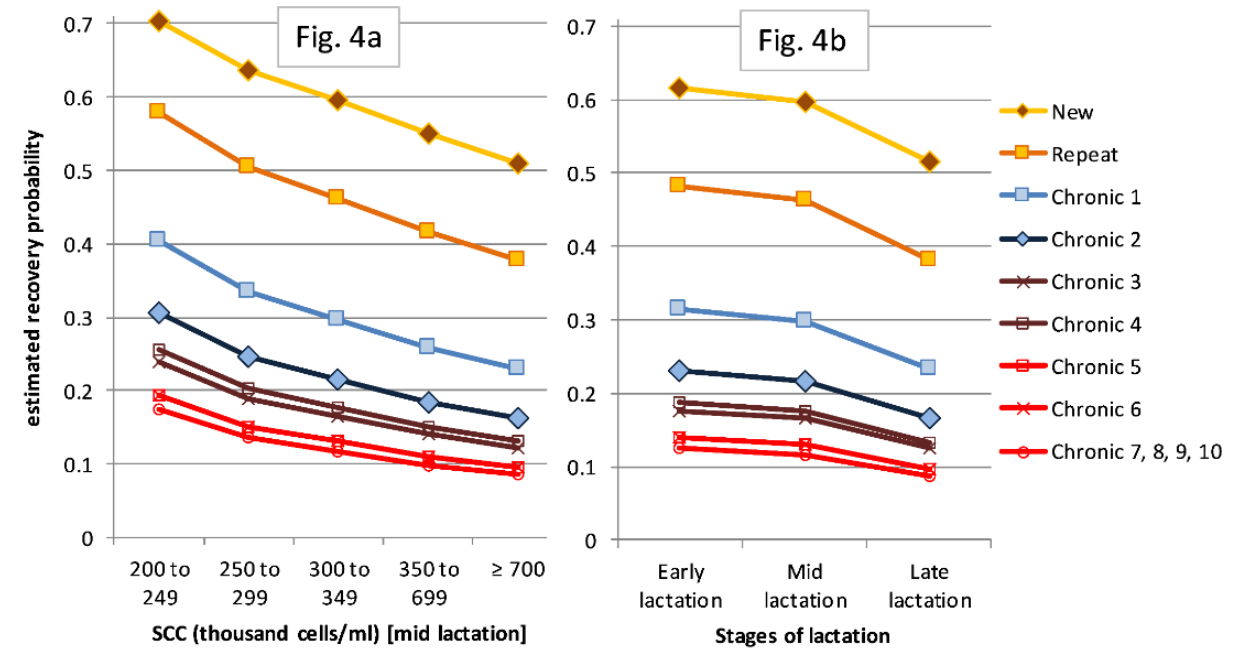
Figure 4: Estimated recovery probabilities for different categories of high SCC, for a third parity cow in a medium sized herd, by magnitude of SCC (Fig. 4a) and by stage of lactation (Fig.